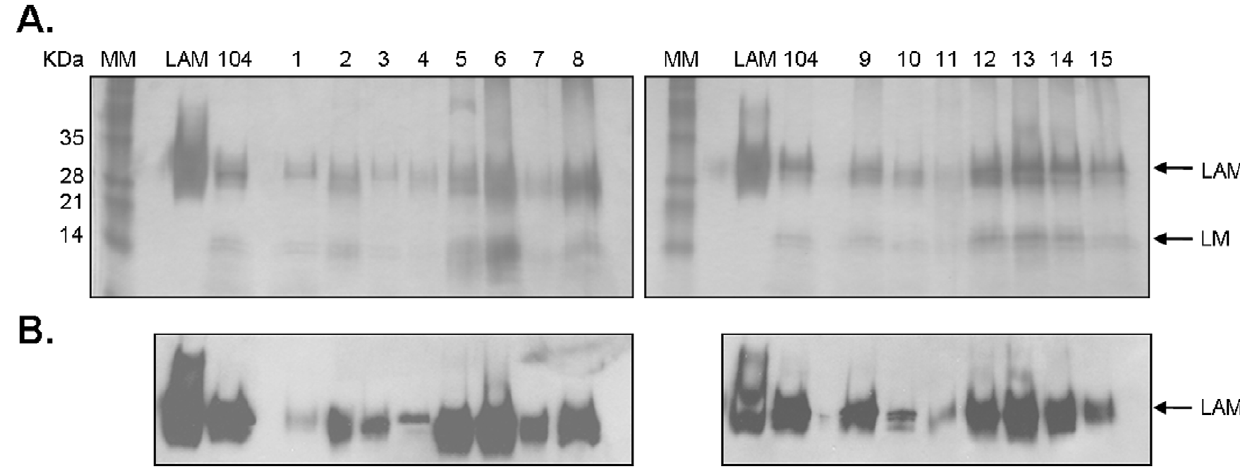
Figure 4. Detection of ManLAM in the cell wall of M.avium spp. isolates. A. PAS-stained 15% SDS-polyacrylamide gel of whole cell lysates normalized by protein content (representative of N=3). M.tb H 37 R v ManLAM was used as a control and clinical isolate MAC 104 as the reference standard; lane MM represents a pre-stained protein ladder. B. Western blot using anti-LAM CS-35 mAb (representative of N=3).